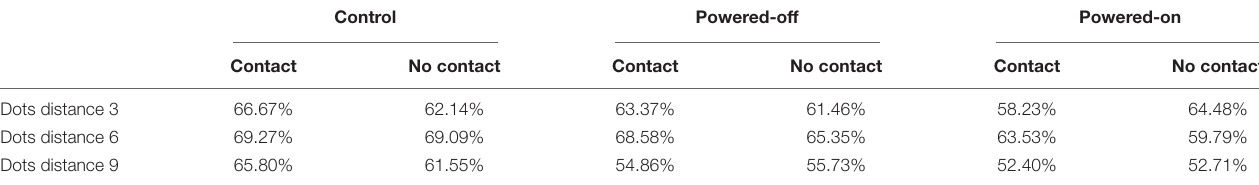
TABLE 1 | The hit rate detail across the experimental conditions in experiment